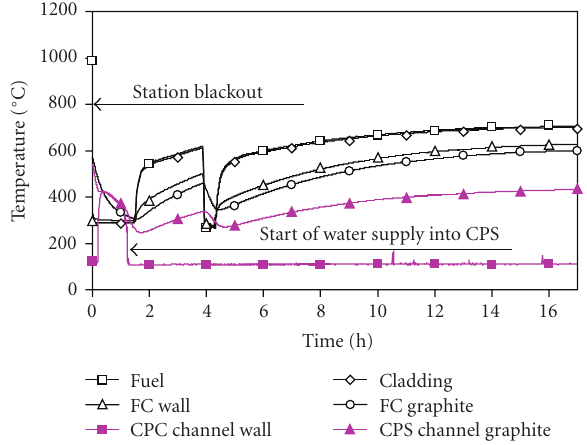
Figure 8: Station blackout case. Heat removal using CPS channels is taken into account. Behaviour of core components temperatures at the elevation 1.75m from core